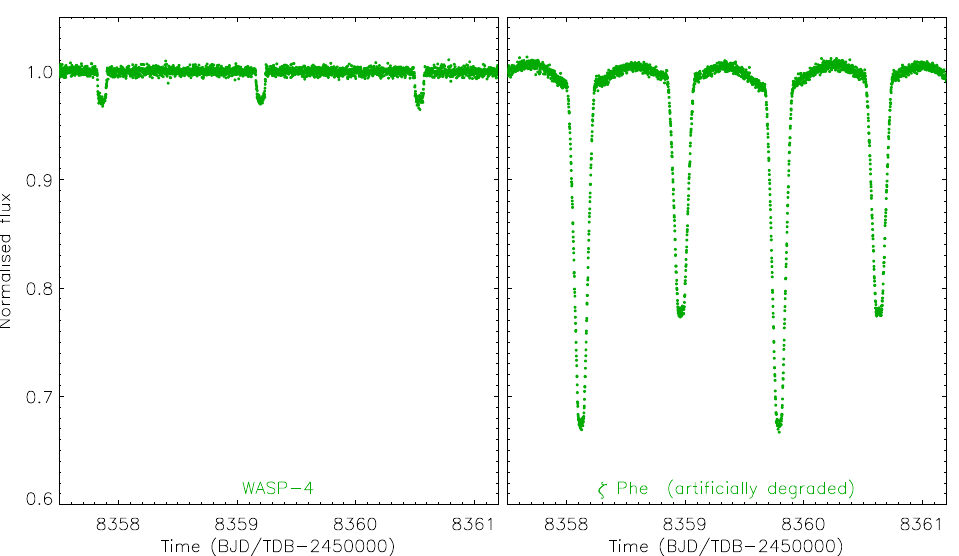
Figure 1. Comparison of the brightness variation of a transiting planet ( left ) and an EB ( right ), both observed by TESS in sector 2. WASP-4 was chosen as it shows one of the deepest planetary transits known. ζ Phe has a typical brightness variation for an EB and was observed by TESS at the same time as WASP-4. The light curve of ζ Phe (brightness V = 4.01) has been artificially degraded so its scatter matches that of the much fainter WASP-4 system ( V = 12.46). The axes are the same on both plots. Only a small fraction of the light curves are shown.